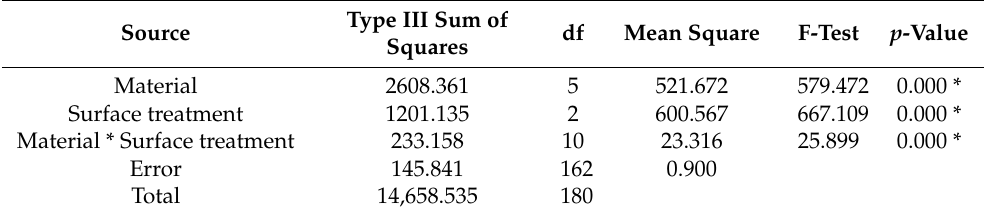
Table 3. Two-way ANOVA results showing combined effect of materials and surface